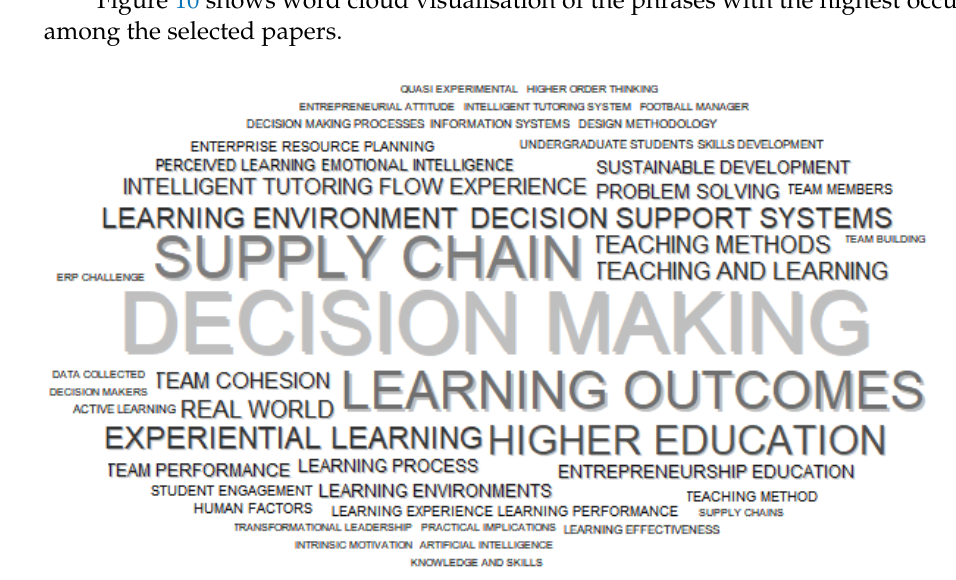
Figure 10. Word cloud phrase occurrence (10+ occurrence); Source: Authors’ work based on Scopus.